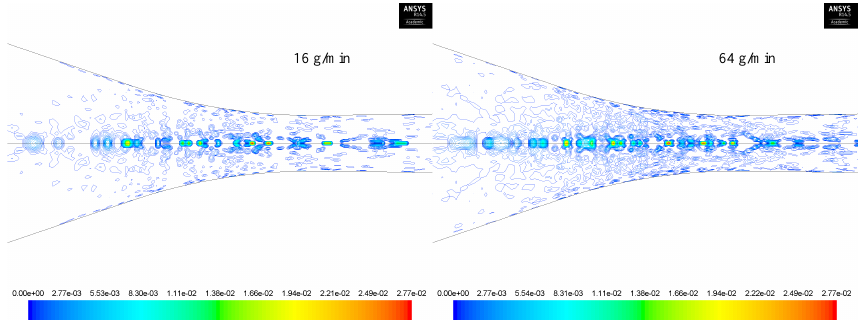
Figure 7. Volume fraction of particles in the throat region.